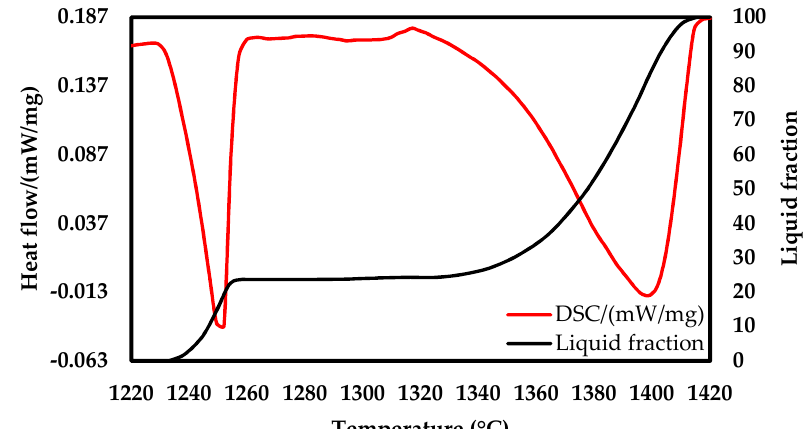
Figure 2. Liquid fraction vs. temperature and heating flow vs temperature curves of the AISI D2 tool steel calculated by differential scanning calorimetry (DSC).